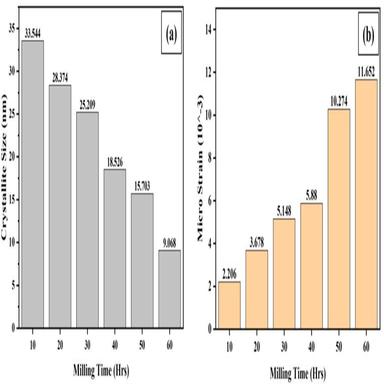
(a) Crystallite size, (b) Micro strain of powders for various hours of MA.